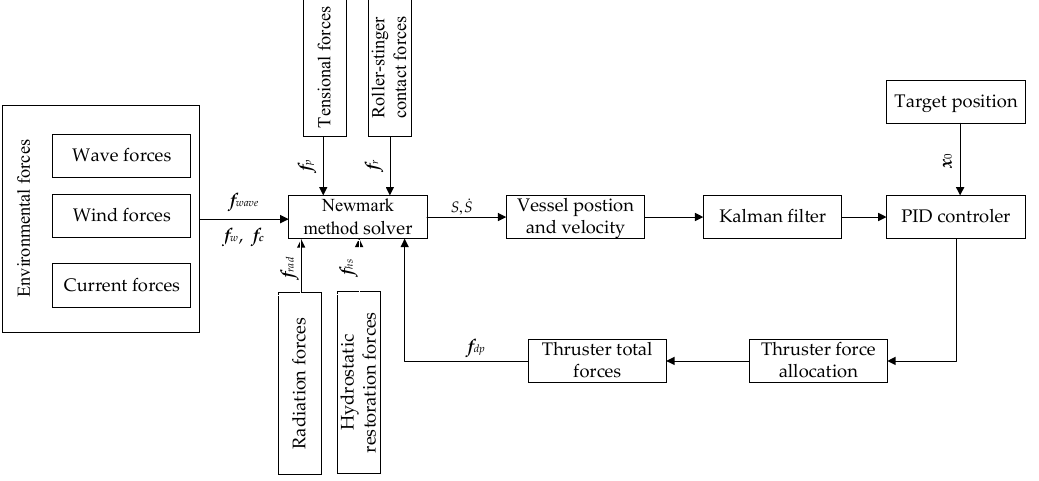
Figure 9. Solution procedure for the coupled model.